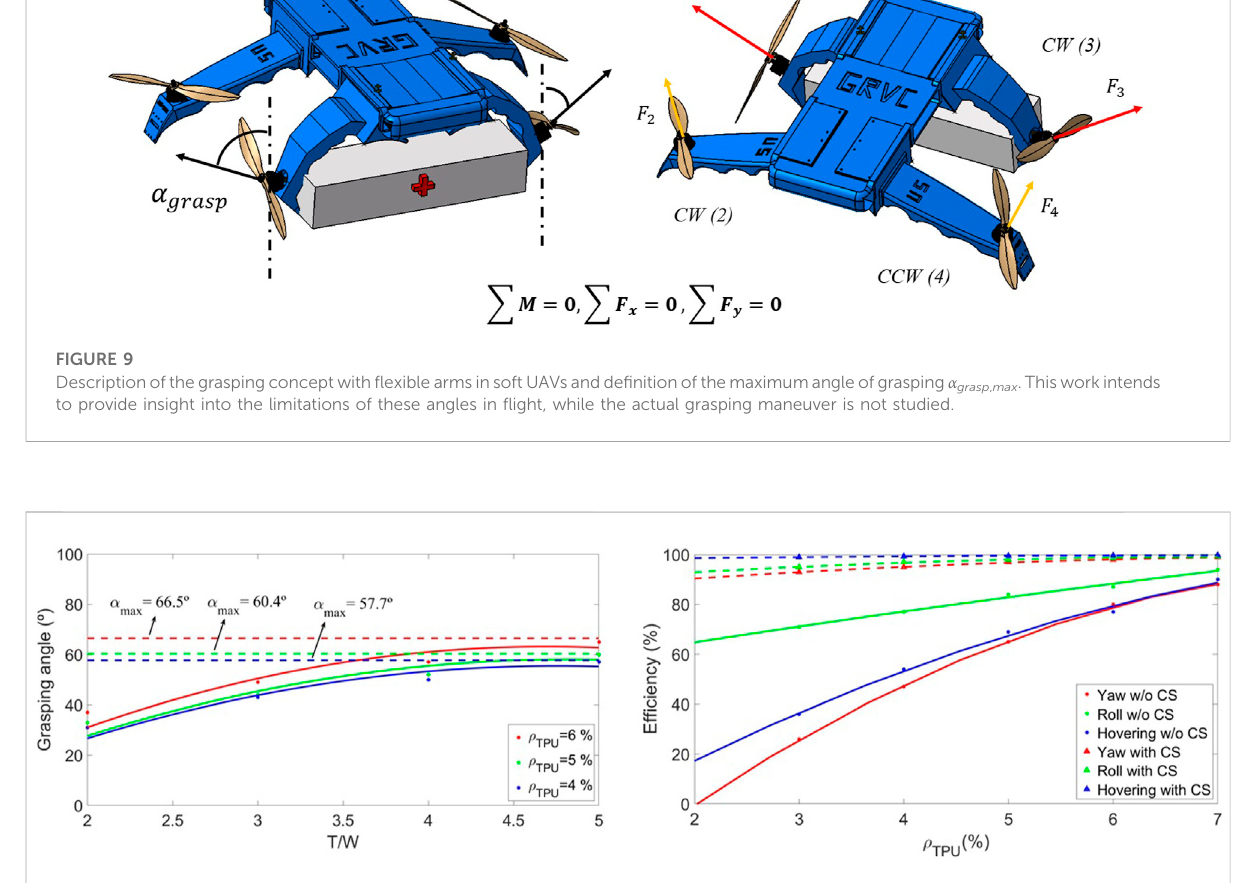
FIGURE 10 Left Figure shows the evolution of the ef fi ciencies of the fl exible UAV when introducing the compensation system CS (triangles) for hovering